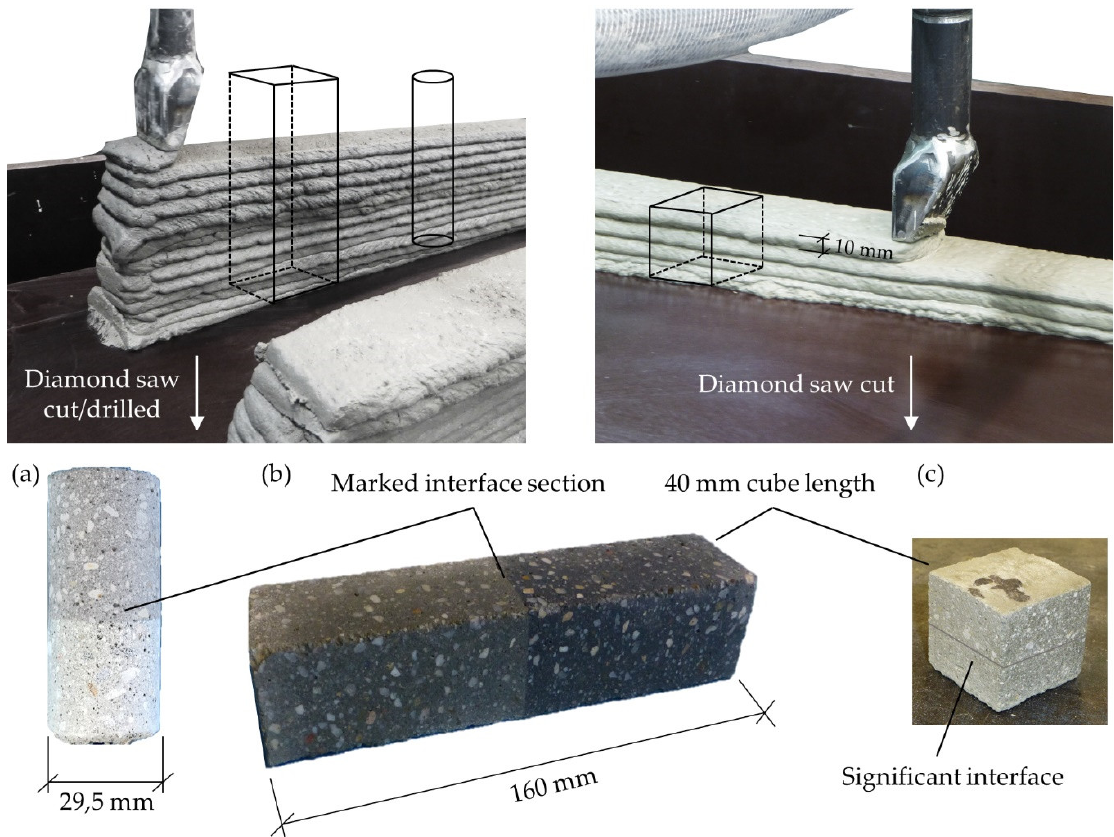
Figure 4. Production process of printed specimens; left for shear and bending experiments and right for tensile testing and bending in U- and V-direction. After curing the specimens were extracted for testing ( a ) shear strength, ( b ) flexural strength and ( c ) tensile strength.